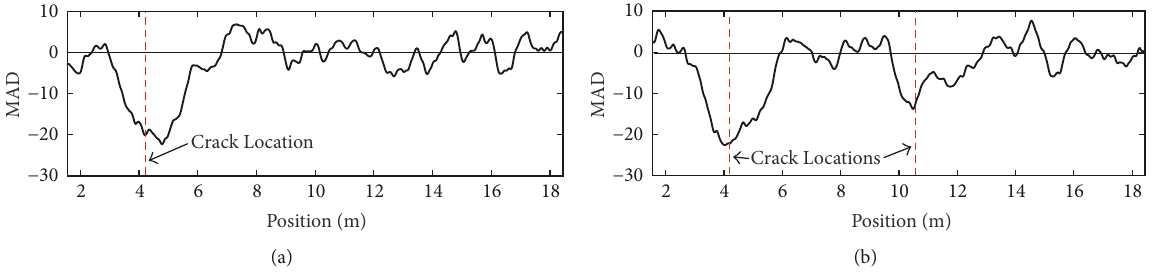
Figure 15: The second damage indicator in presence of noise: (a) the first damage case and (b) the second damage